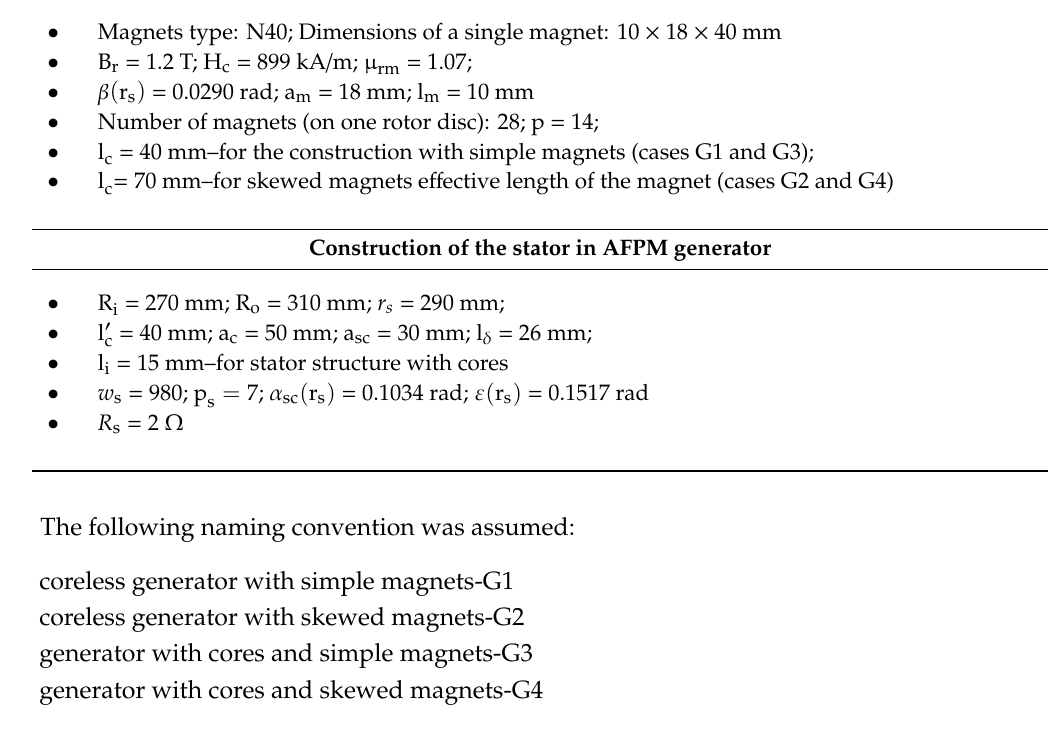
Figure 19. Rotor discs; ( a ) simple magnets; ( b ) skewed magnets. Table 1. Design AFPMG